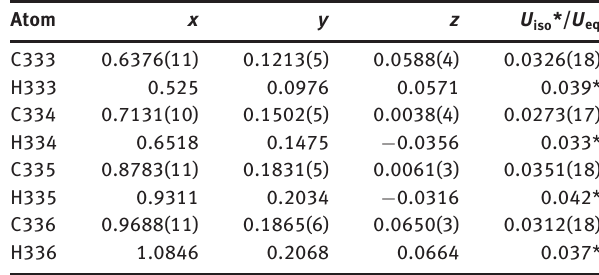
Table 2: Fractional atomic coordinates and isotropic or equivalent isotropic displacement parameters (Å 2